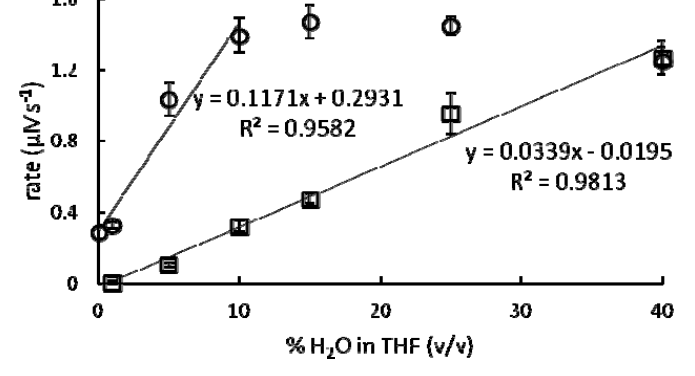
- ( ○ ) or Eu(NO ) -catalyzed ( □ ) 3 3 3 O/THF mixtures (v/v). Regression lines 2